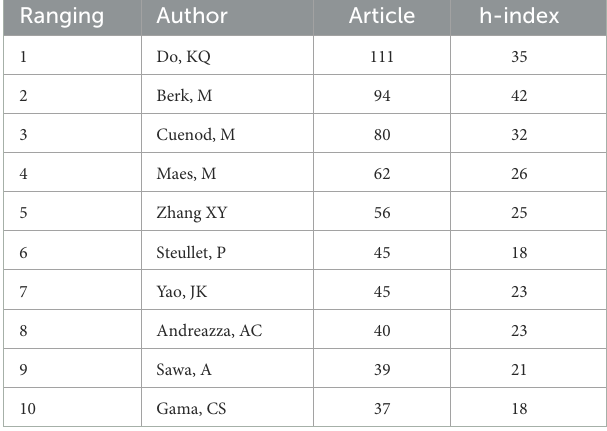
TABLE 1 Top 10 authors with the most publications in the field of schizophrenia and oxidative